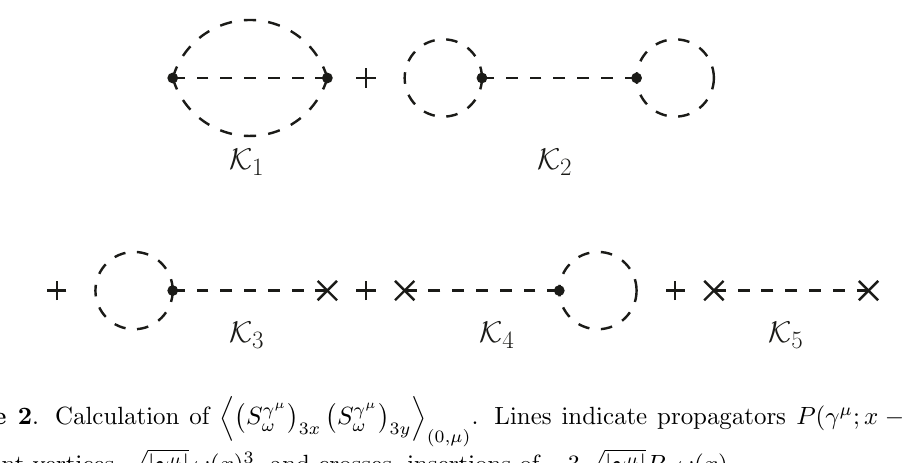
p 3 (cid:13) (cid:22) P 0 ! ( x (cid:0) j j